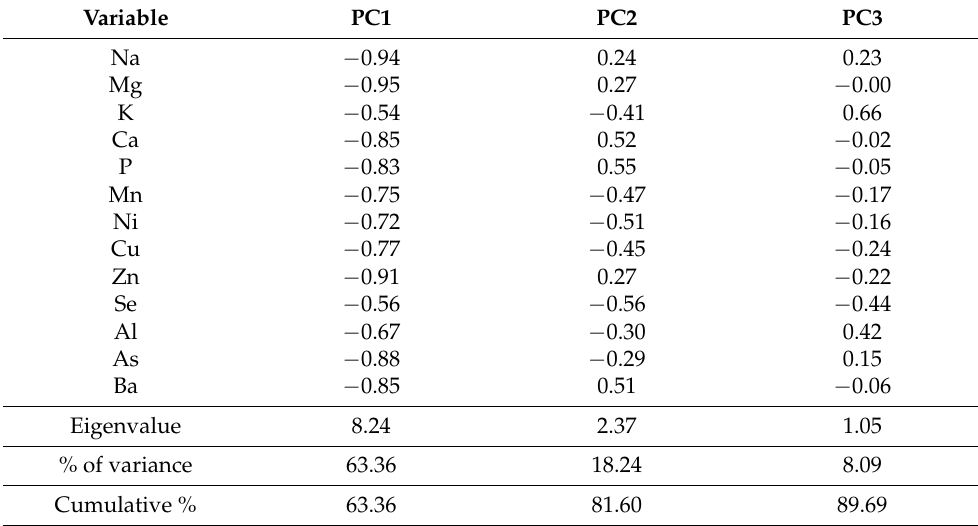
Table 3. Correlations between the principal components and the original